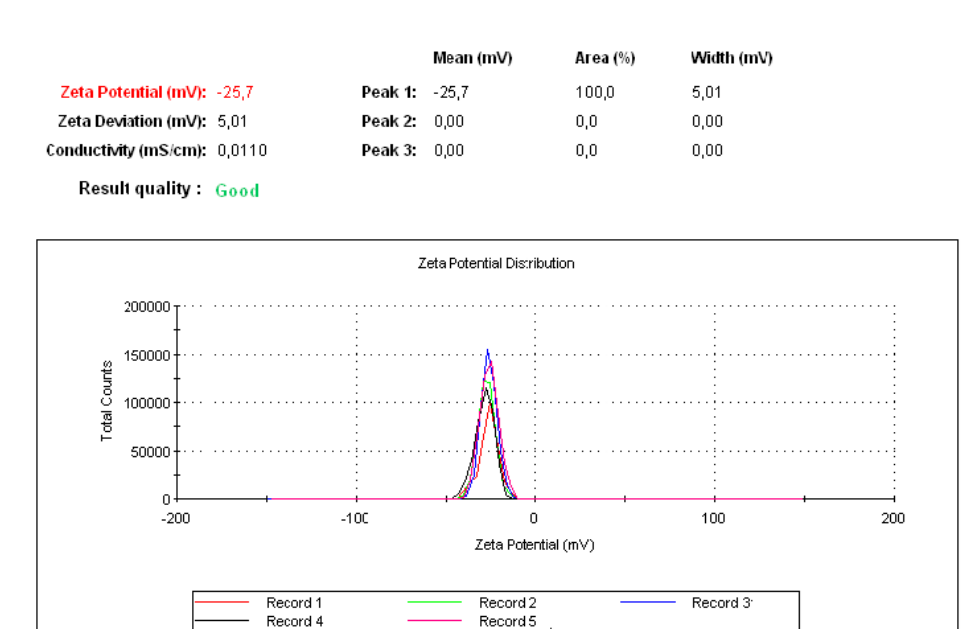
Figure 3. Zeta potential measurement after five successful running data. Each one was run five times with a delay of 5 s after each measurement.